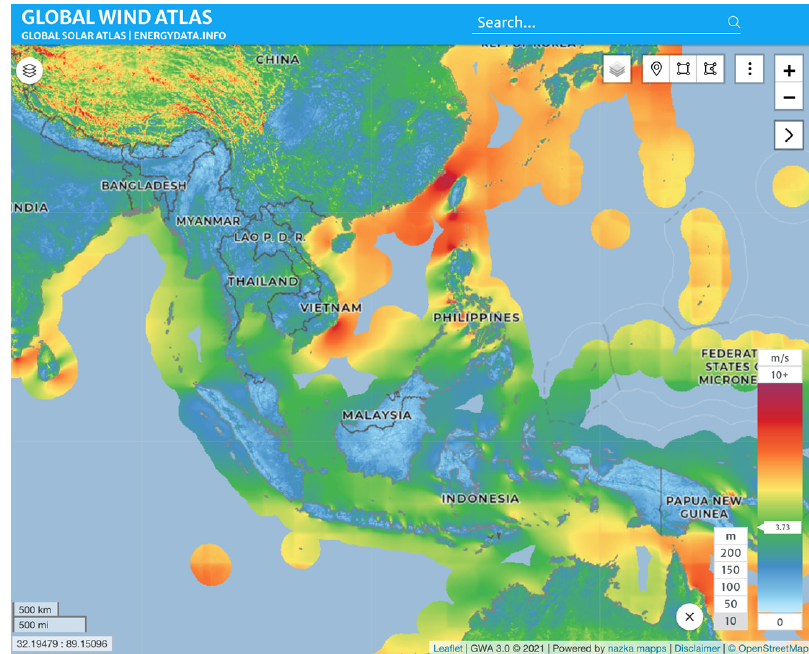
Figure 7. Wind speed map at 10 m above sea level in Southeast Asia [24] .